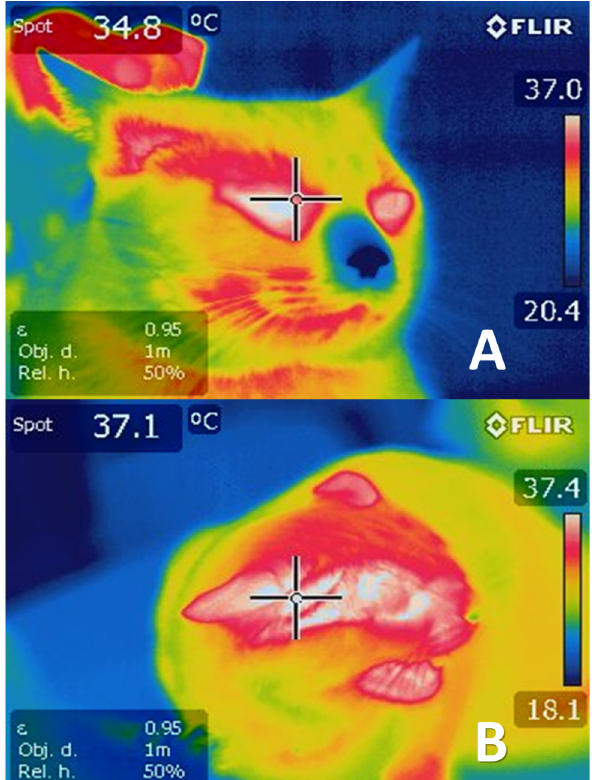
Figure 6. Thermogram of an idle cat ( A ) and one exposed to a predator ( B ). The cat at rest (thermogram ( A )) has an ocular temperature of 34.8 °C, but the one in thermogram ( B ), which was exposed to a dog for 60 s, shows an ocular and auditory conduct temperature of 37.1 °C. Thus, the ocular temperature increased by around 2 °C in the presence of the adverse stimulus. The cat in this image was exposed to the predator at a distance of 1 m for only 60 s, so no harm or injury occurred. This protocol complies with Mexico’s regulations for the care and use of experimental animals. (Images obtained with an FLIR E50 camera with an 18-mm FOL lens at a resolution of 240 × 180 pixels, (emissivity = 0.95, distance= 1 m)).